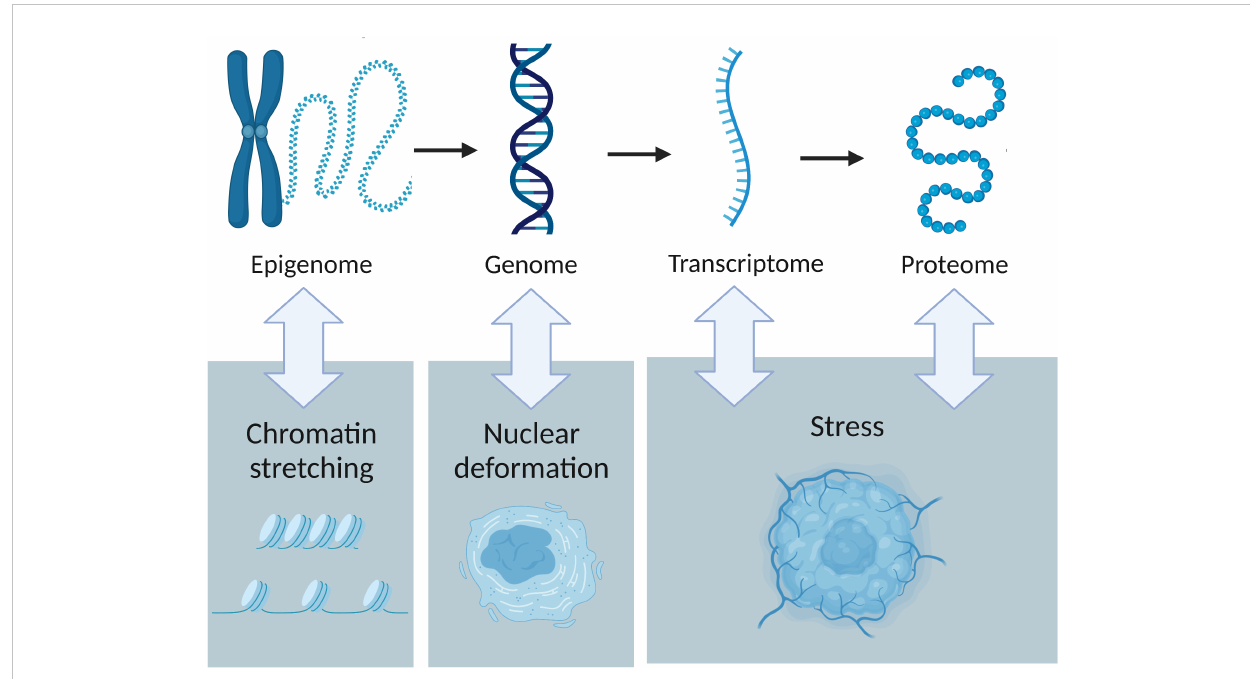
FIGURE 2 The interactions between tumour omics and the physical traits of cancer. Epigenetics is in fl uenced by chromatin stretching, nuclear deformation leads to genome instability and stress affects both transcription and protein